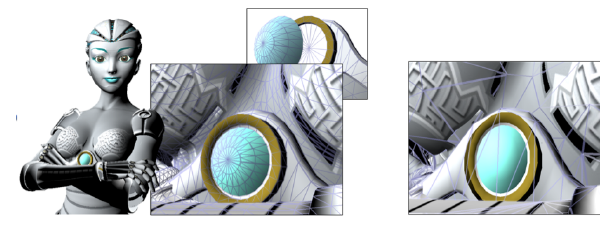
Fig. 4. Snapshots of the geometry of the 3D model obtained. Note the variety of the decorative elements and, in close-up, their intricate details.